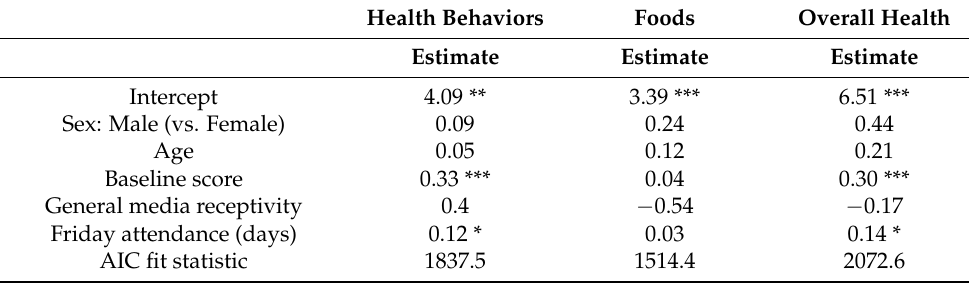
Table 6. The HLM models predicting the health outcomes, exploring Friday attendance. Health Behaviors Foods Overall Health Estimate Estimate Estimate Intercept 4.09 ** 3.39 *** 6.51 *** Sex: Male (vs. Female) 0.09 0.24 0.44 Age 0.05 0.12 0.21 Baseline score 0.33 *** 0.04 0.30 *** General media receptivity 0.4 − 0.54 − 0.17 0.12 * 0.03 0.14 *